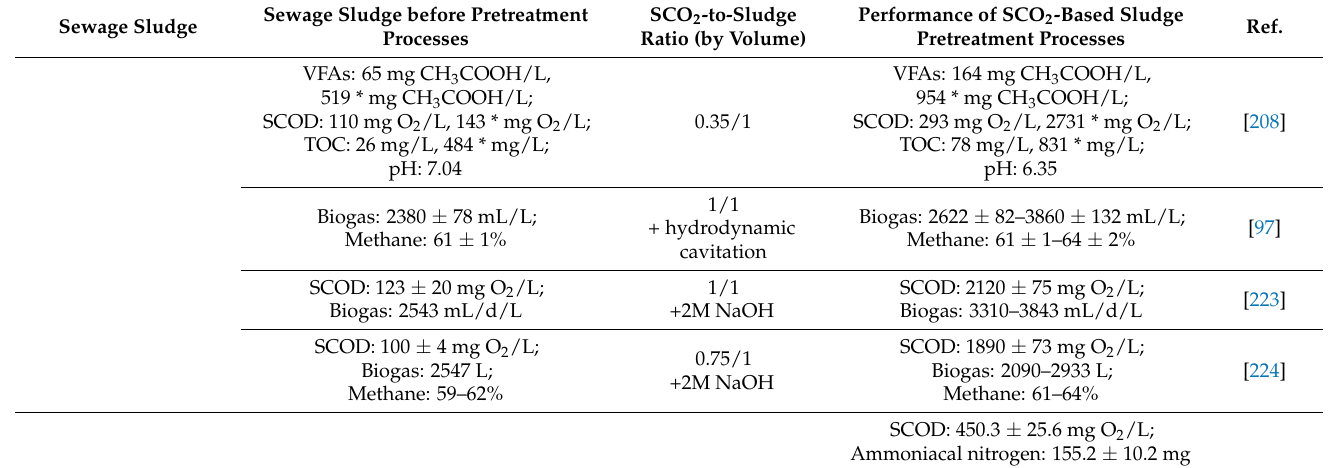
SCO 2 -to-Sludge Performance of SCO 2 -Based Sludge Ratio (by Volume) Pretreatment Processes